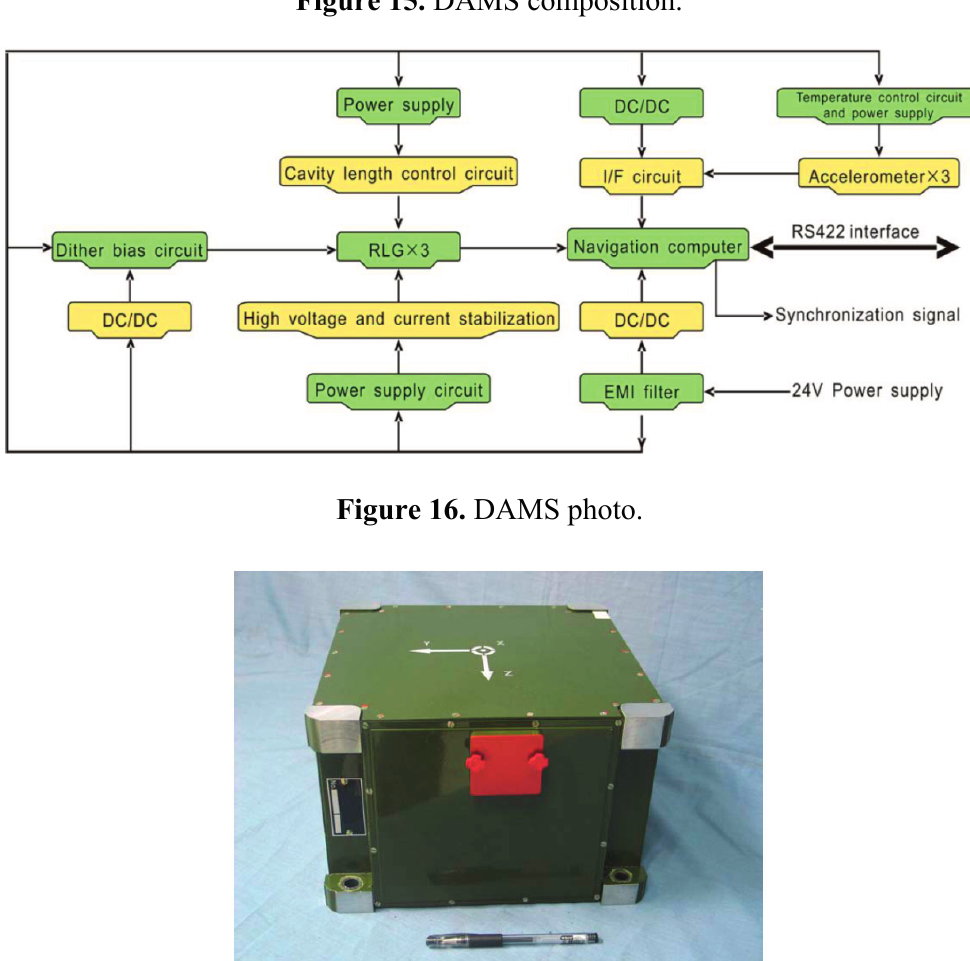
Figure 15. DAMS composition.